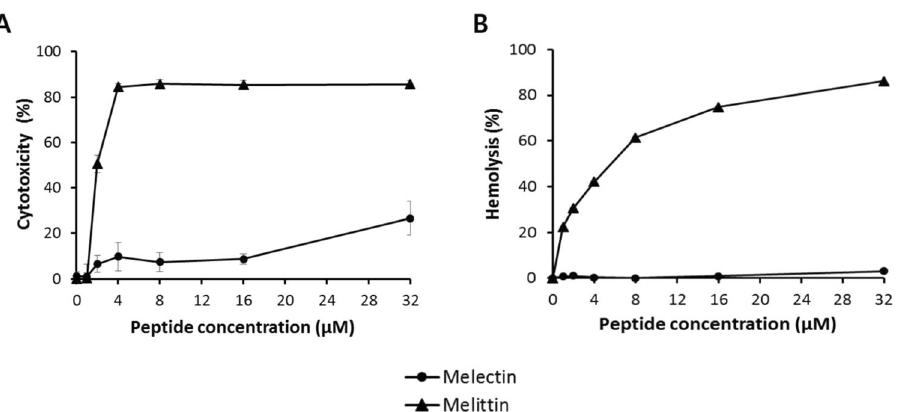
Figure 2. Cytotoxicity of antimicrobial peptides. ( A ) Human fibroblasts were used to evaluate the cytotoxicity of peptides. Cytotoxicity was measured through the MTT assay. ( B ) Hemolytic activity of the peptides against red blood cells. The graphs were derived from average values of three independent